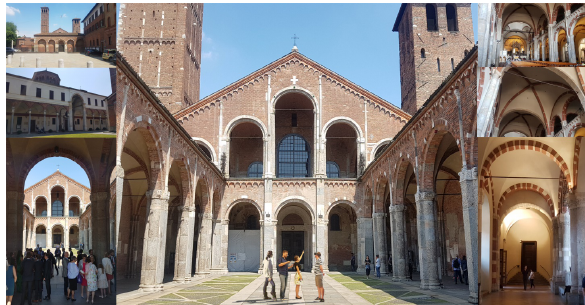
Figure 1. The Basilica of Sant’Ambrogio and its distinctive architectural elements that add prestige to the image of the city of